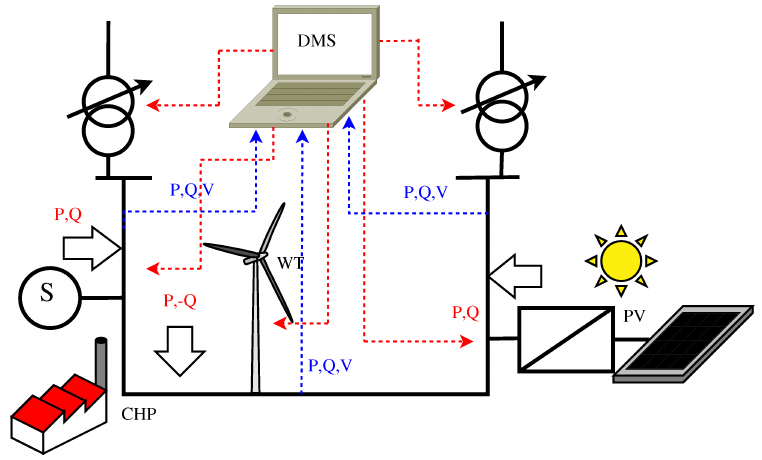
Figure 18. Decentralized control: coordinated dispatching and voltage profile